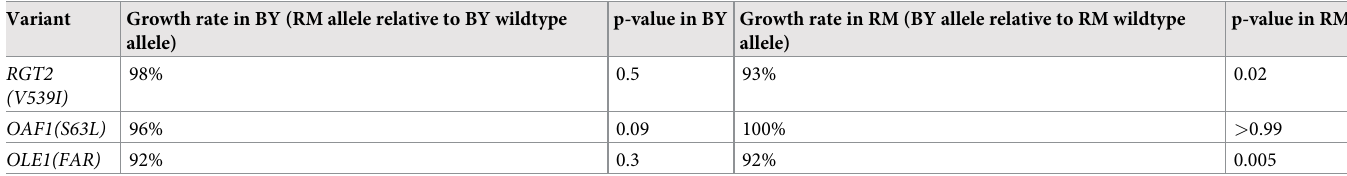
Table 1. Effects of causal hotspot variants on growth rates. Variant Growth rate in BY (RM allele relative to BY wildtype allele)